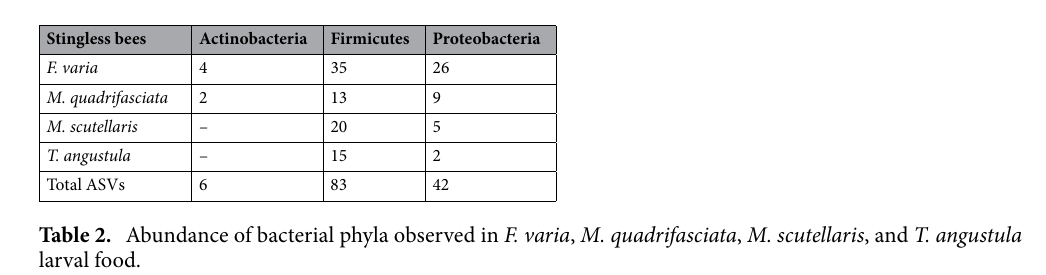
Figure 1. ( A ) Venn Diagram of ASVs classified for stingless bees; ( B ) Genus × Family histogram of 15 genera most abundant.